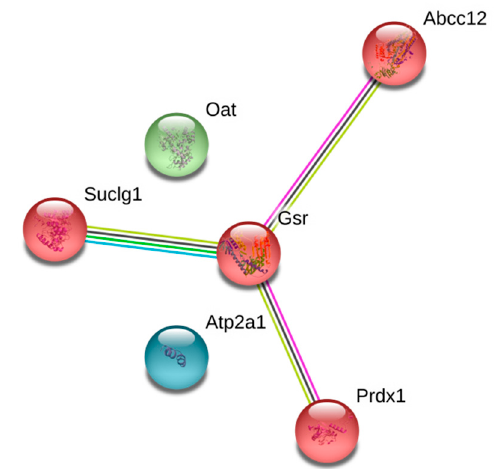
Figure 3. Functional links between mitochondrial ubiquitinated proteins of MPTP-treated mice. The links have been composed by the STRING database resource. Abbreviations used by the STRING